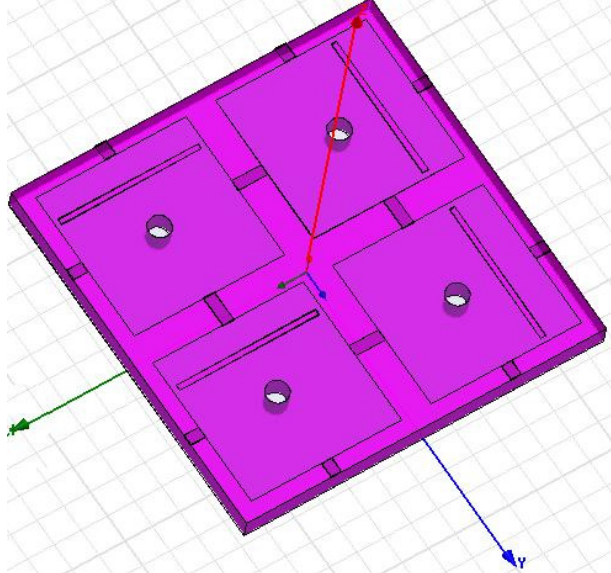
Figure 5 : The 3-D sketch of the modified HIGP metamaterial absorber